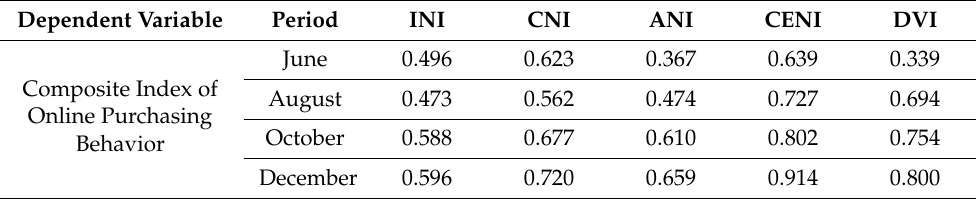
Table 6. Correlation of the studied indicators during